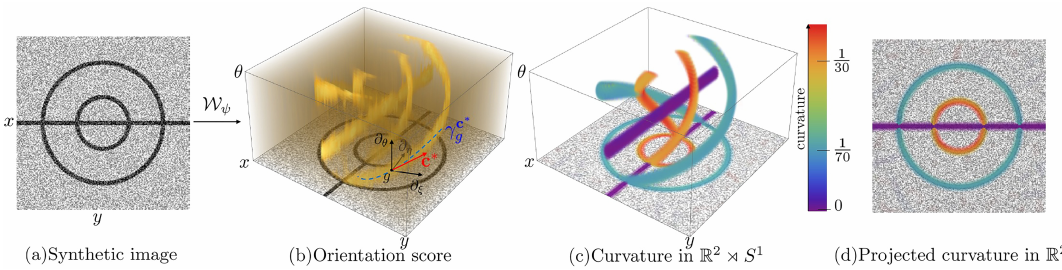
Figure 3. Validation of exponential curvature estimation on ( a ) a synthetic image with SNR = 1; ( b ) the lifted data representation; ( c ) the curvature map via best exponential curve fit; ( d ) the projected curvature